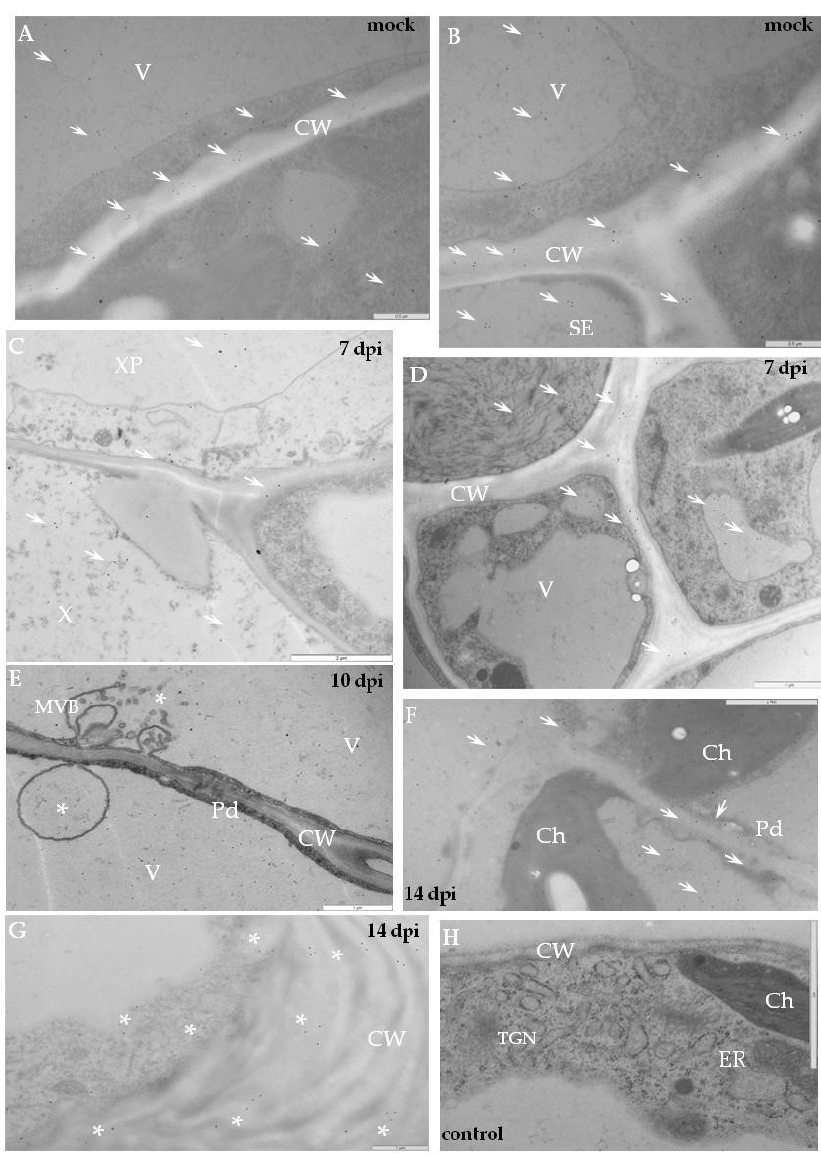
Figure 5. Immunogold labelling of xylan-1/xyloglucan for potato–PVY NTN incompatible interaction. ( A ) Xylan-1/xyloglucan localisation (arrows) in cell wall, vacuole and in cytoplasm, also associated with membranes. Bar 0.5 µm ( B ) Xylan-1/xyloglucan localisation (arrows) in companion cells and sieve element of mock-inoculated potato Sárpo Mira leaf. Depositions are visible in the cell wall, vacuole and cytoplasm. Bar 0.5 µm ( C ) Xylan-1/xyloglucan deposition (arrow) in xylem tracheary element and xylem parenchyma seven days post-PVY inoculation. Bar 2 µm ( D ) Xylan-1/xyloglucan localisation (arrows) inside sieve element, also in cell wall and vacuole of phloem parenchyma cells seven days post-PVY NTN inoculation. Bar 1 µm ( E ) Deposition in vacuole with multivesicular bodies (*, MVB) 10 days past virus inoculation. Bar 1 µm ( F ) Xyloglucan localisation (arrows) closely related with cell wall plasmodesmata 14 days after PVY inoculation in palisade mesophyll cell. Bar 1 µm ( G ) Xyl-1 deposition (*) in cell wall and cytoplasm in collenchyma of potato S á rpo Mira leaf 14 days post virus inoculation. Bar 1 µ m. ( H ) Lack of gold deposition in mesophyll of potato S á rpo Mira leaf–PVY NTN compatible interaction when primary antibodies were omitted (control). Bar 2 µ m. Ch—chloroplast, CW—cell wall, MVB—multivesicular bodies, Pd—plasmodesmata, SE—sieve element, TGN—trans-Golgi network, X—xylem tracheary element, XP—xylem